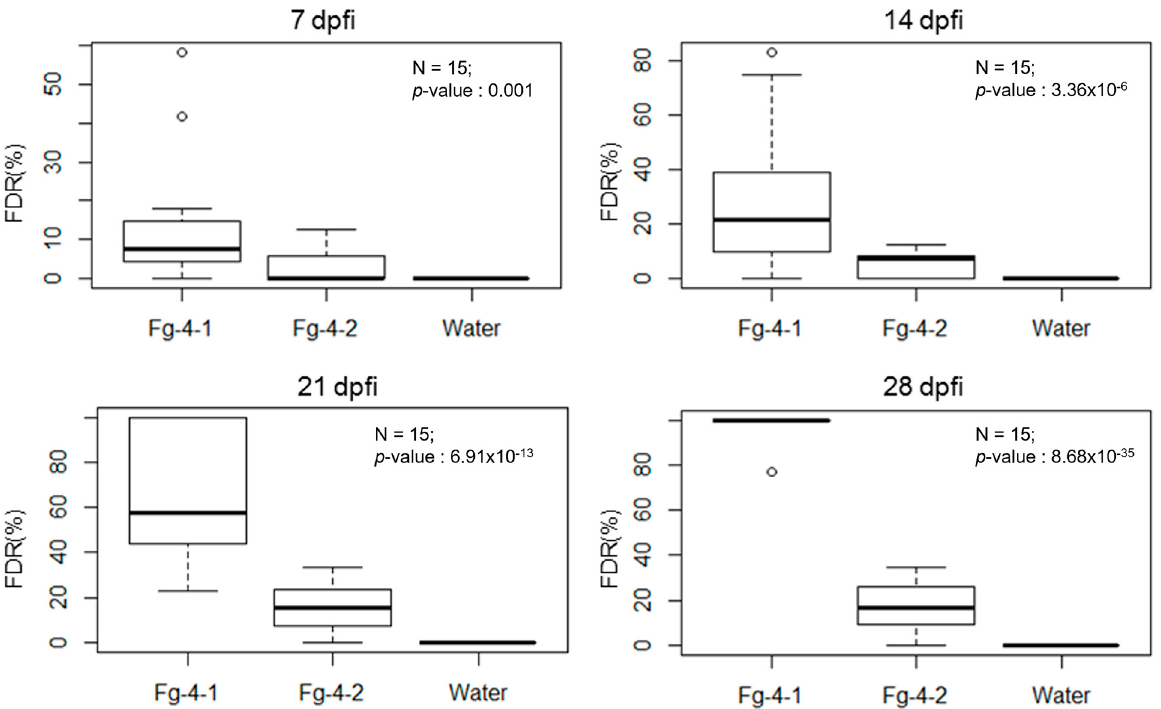
Figure 4. Mean FHB-damaged rachises rates (FDR) as a percentage after inoculation of wheat line NIL-S with F. graminearum isolates Fg-4-1, Fg-4-2, and sterile water in 7, 14, 21, and 28 dpi. Virus-free strain Fg-4-1 shows greater numbers of damaged rachises when inoculated to wheat heads at 7–28 dpi when compared to FgV1-SD4-infected strain Fg-4-2 inoculation and mock water control.